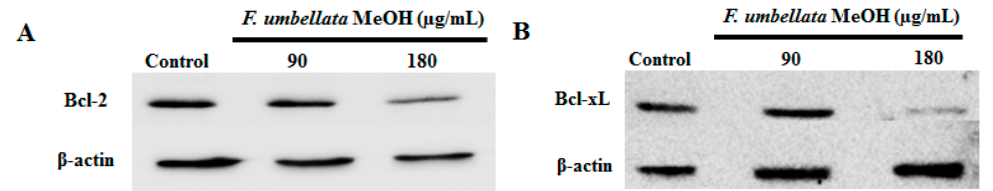
Figure 7. Effects of F. umbellata extract on Bcl2 and Bcl-xL content. Western blot analysis of Bcl-2 ( A ) and Bcl-xL ( B ) protein contents in MDA-MB-231 cells treated with 90 and 180 μ g/mL of F. umbellata MeOH extract for 24 h.